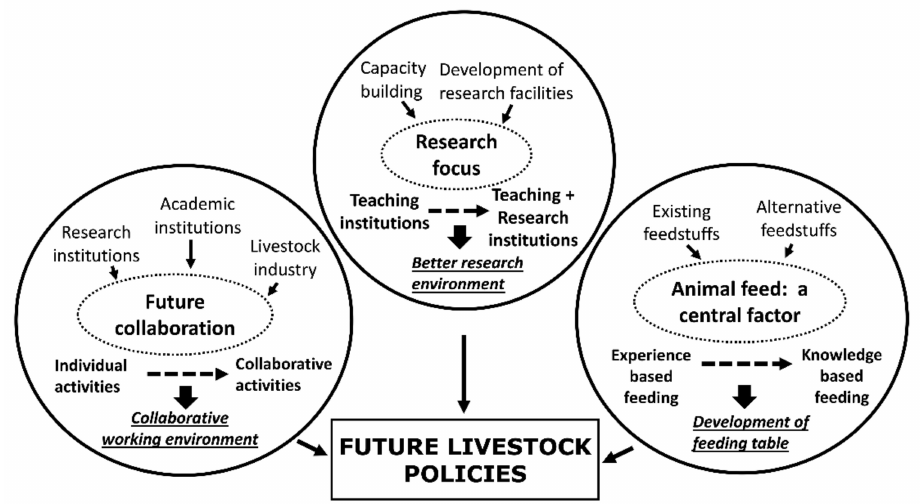
Figure 5. Formulation of future livestock policies in Nepal. Future livestock policies should focus on creating a better research environment and collaborative networks among research, academic, and industry sectors where animal nutrition should be recognized as a central player to improve existing production systems and exploit the genetic potentials of future livestock production